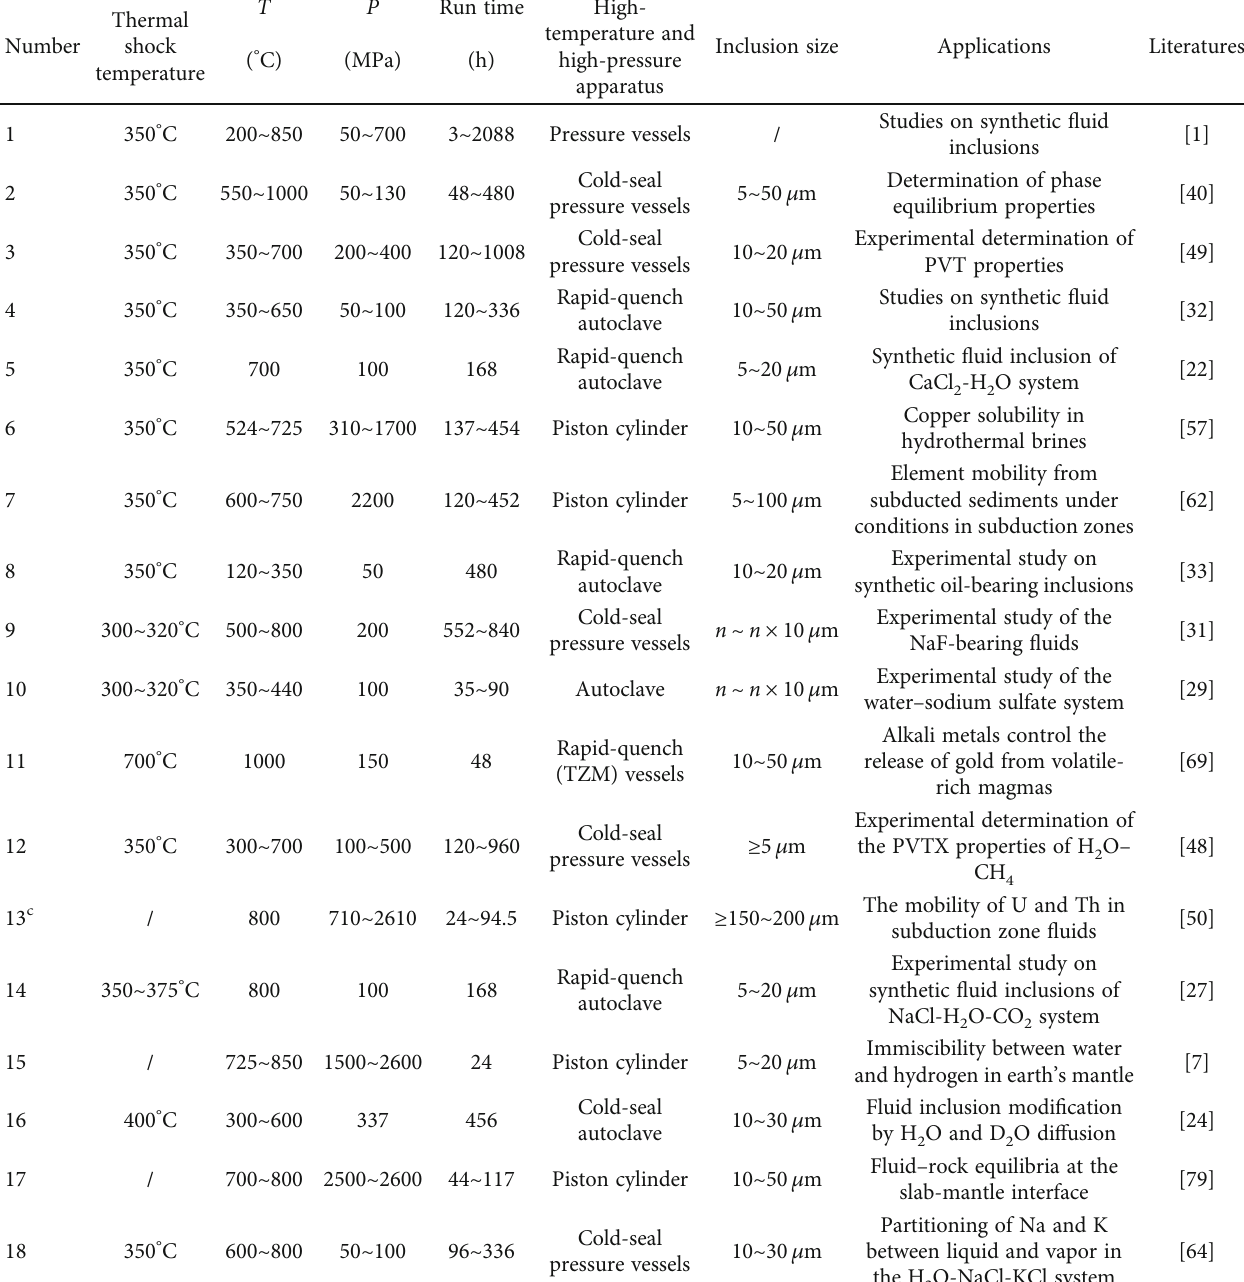
Table 1: Some typical applications of the prefracturing FIS techniques with thermal shock procedure.